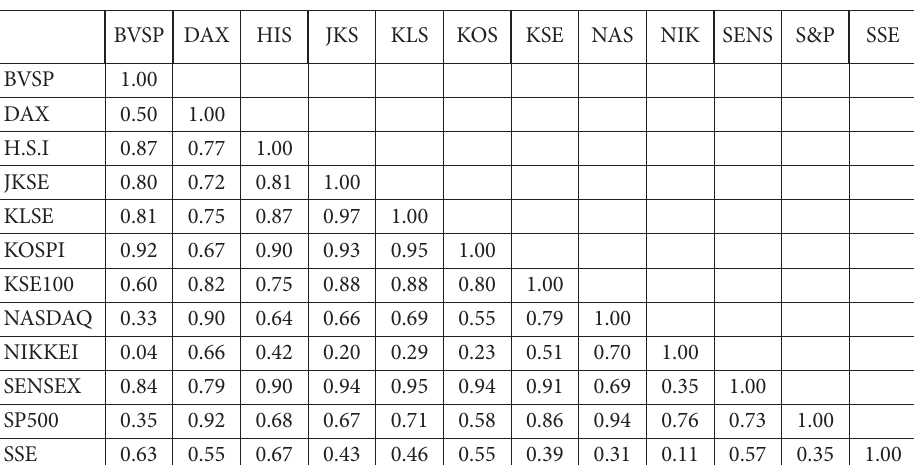
Table 3. Correlation